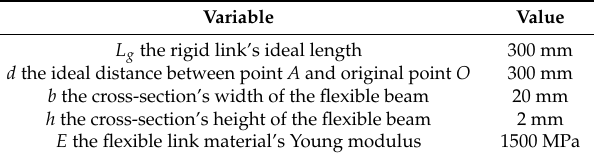
Table 1. The slider crank mechanism’s dimensional and material variables.